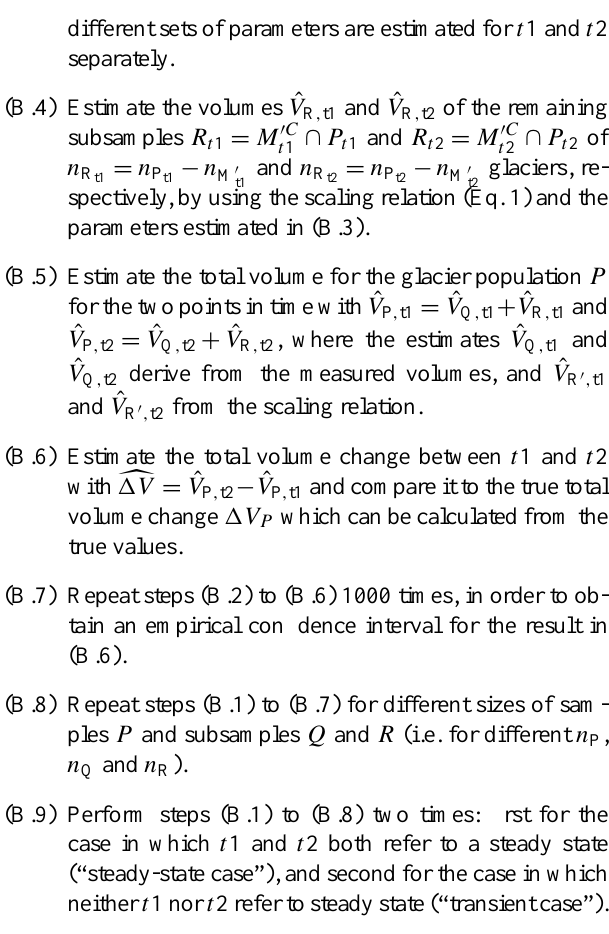
different sets of parameters are estimated for t 1 and t 2